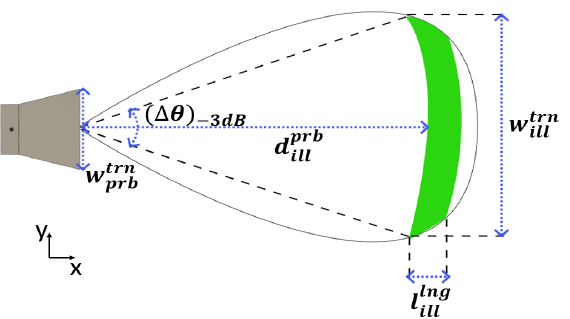
Figure 1. The illumination area of the UWB antenna for microwave imaging.